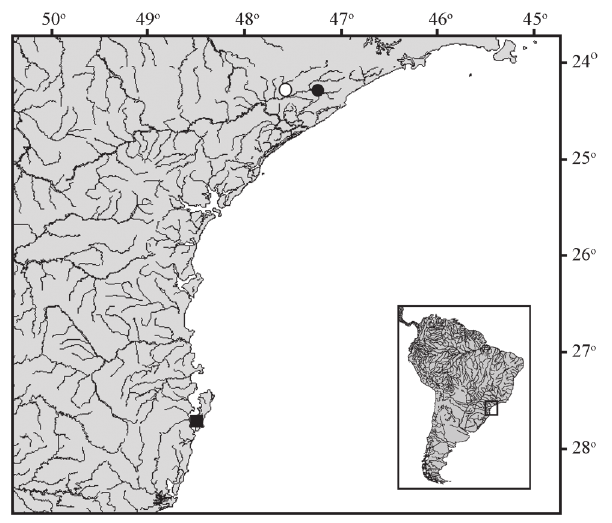
Fig. 6. Geographic distribution of Listrura camposi (circles) and Listrura sp. (square) from município de Florianópolis; Southeastern Brazil, Santa Catarina to São Paulo States. Open circle indicates the type locality of L. camposi .